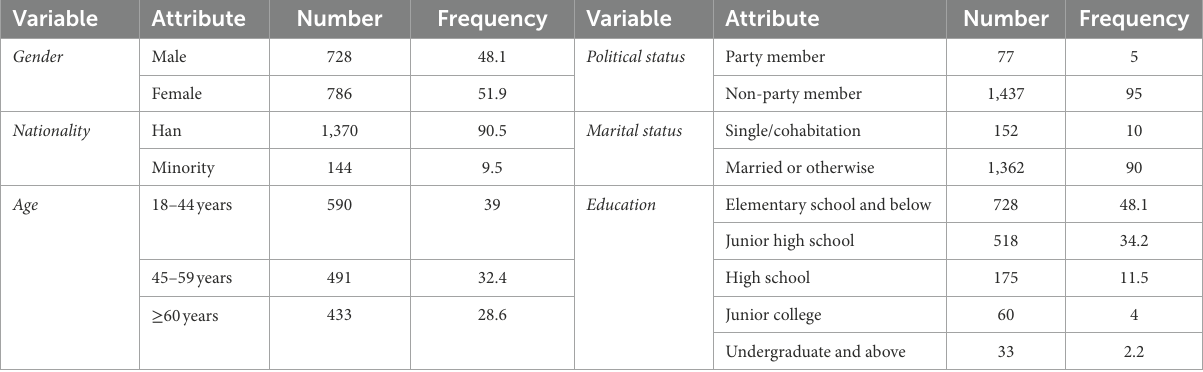
TABLE 1 Demographic characteristics of the